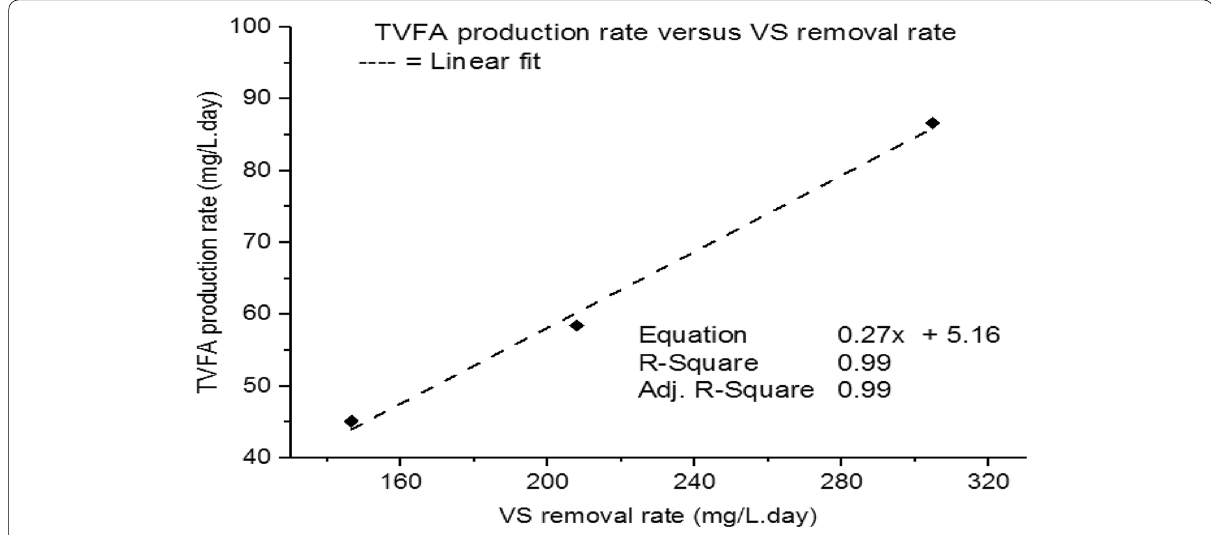
Fig. 2 TVFA production rate verses VS removal